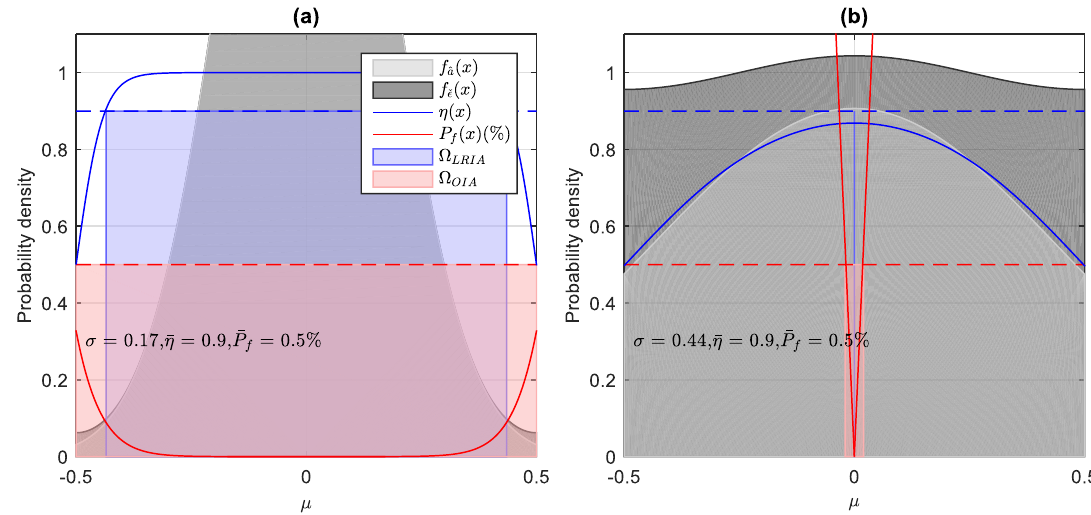
Figure 3. Comparison of the acceptance region determined with the FF-approach and FL-approach with different underlying model in the one-dimensional case. ( a ) stronger underlying model ( b ) weaker underlying model.